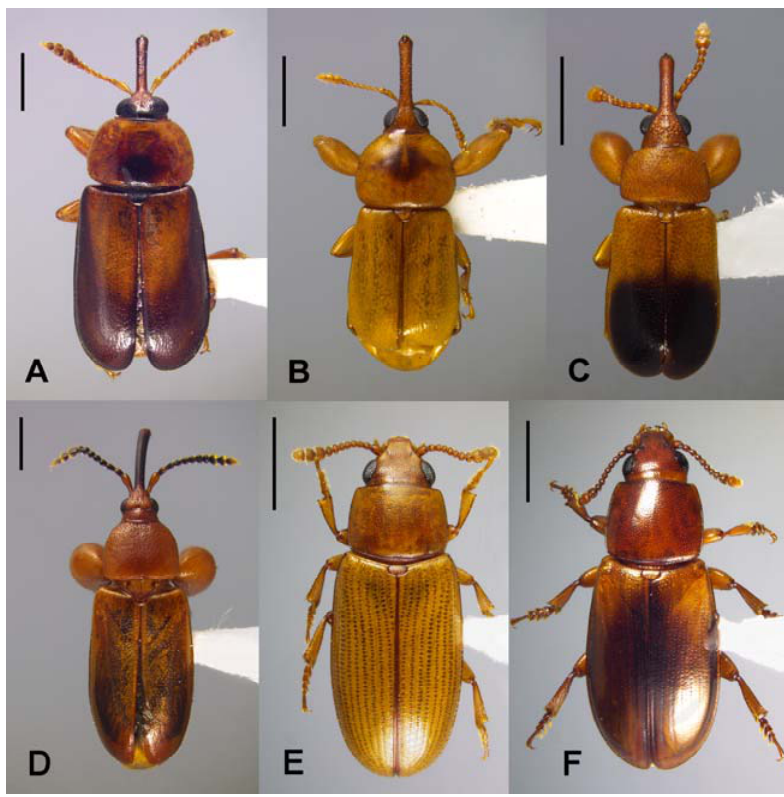
Figure 1. Representatives of the six major lineages of Coleoptera inhabiting New World cycads, dorsal views: ( A ) Protocorynus bontai O’Brien and Tang, male; ( B ) Notorhopalotria montgomeryensis O’Brien and Tang, male; ( C ) Rhopalotria ( R .) dimidiata Chevrolat, male; ( D ) Parallocorynus ( Neocorynus ) schiblii Tang and O’Brien, male; ( E , F ) Pharaxonotha sp. and Erotylidae, undescribed genus inhabiting a male cone of Ceratozamia vovidesii Pérez ‐ Farr. and Iglesias; scale bars = 1 mm.